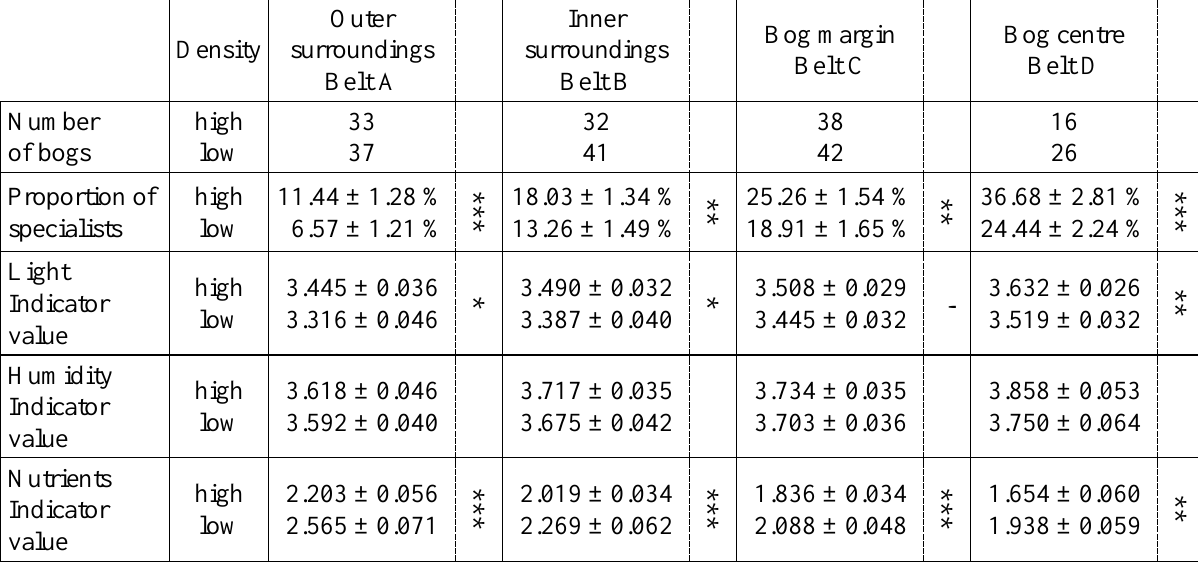
Table 5. Site conditions in Belts A, B, C and D for high-density and low-density bogs. Significance levels for the differences between values for high and low density (rank sum test): *** < 0.001, ** < 0.01, * < 0.05, ' < 0.1.